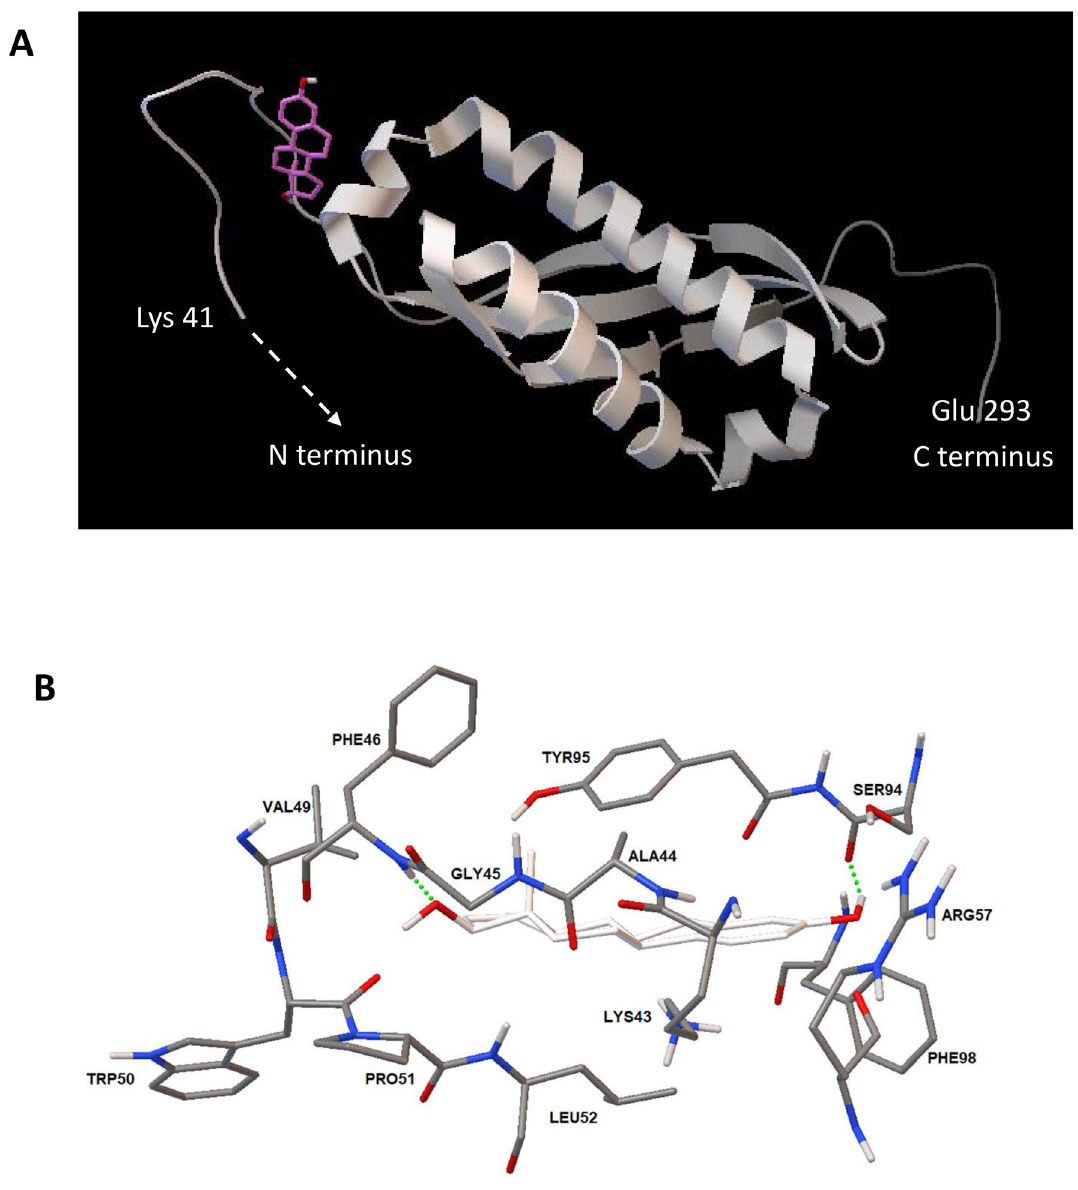
Figure 7. 3D modeling of the potential interaction of the Lactobacillus crispatus CIP104459 SPFH domain- containing protein (NCBI Reference Sequence: WP_013086692.1) with 17β-estradiol. ( A ) Illustration of the sub-membrane domain of the L. crispatus SPFH domain-containing protein showing its potential interaction with 17β-estradiol (pink). ( B ) Calculated 17β-estradiol binding site on the L. crispatus SPFH domain-containing protein determined with AutoDock 4.2 (17β-estradiol appears in white and the hydrogen bonds between 17β-estradiol and amino acids are shown as green dotted